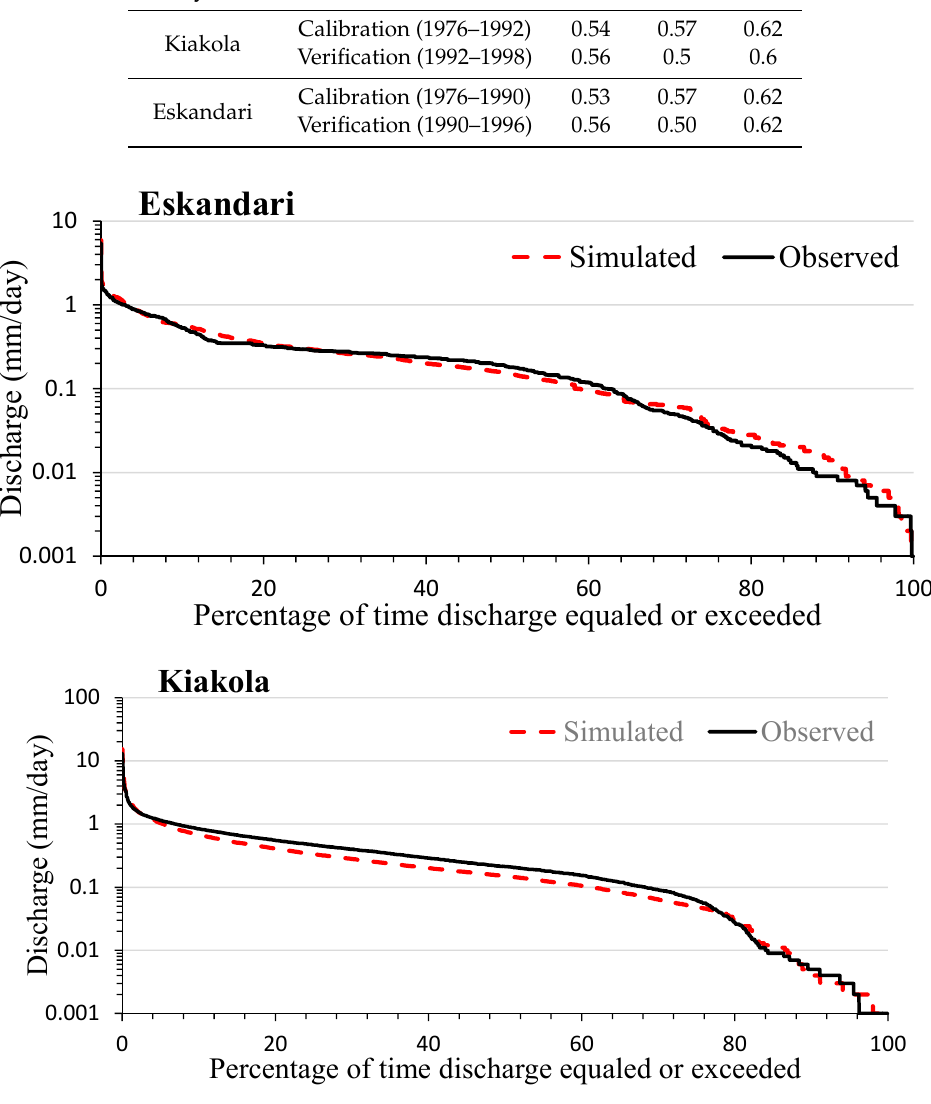
Figure 7. Flow duration curves for daily discharge.